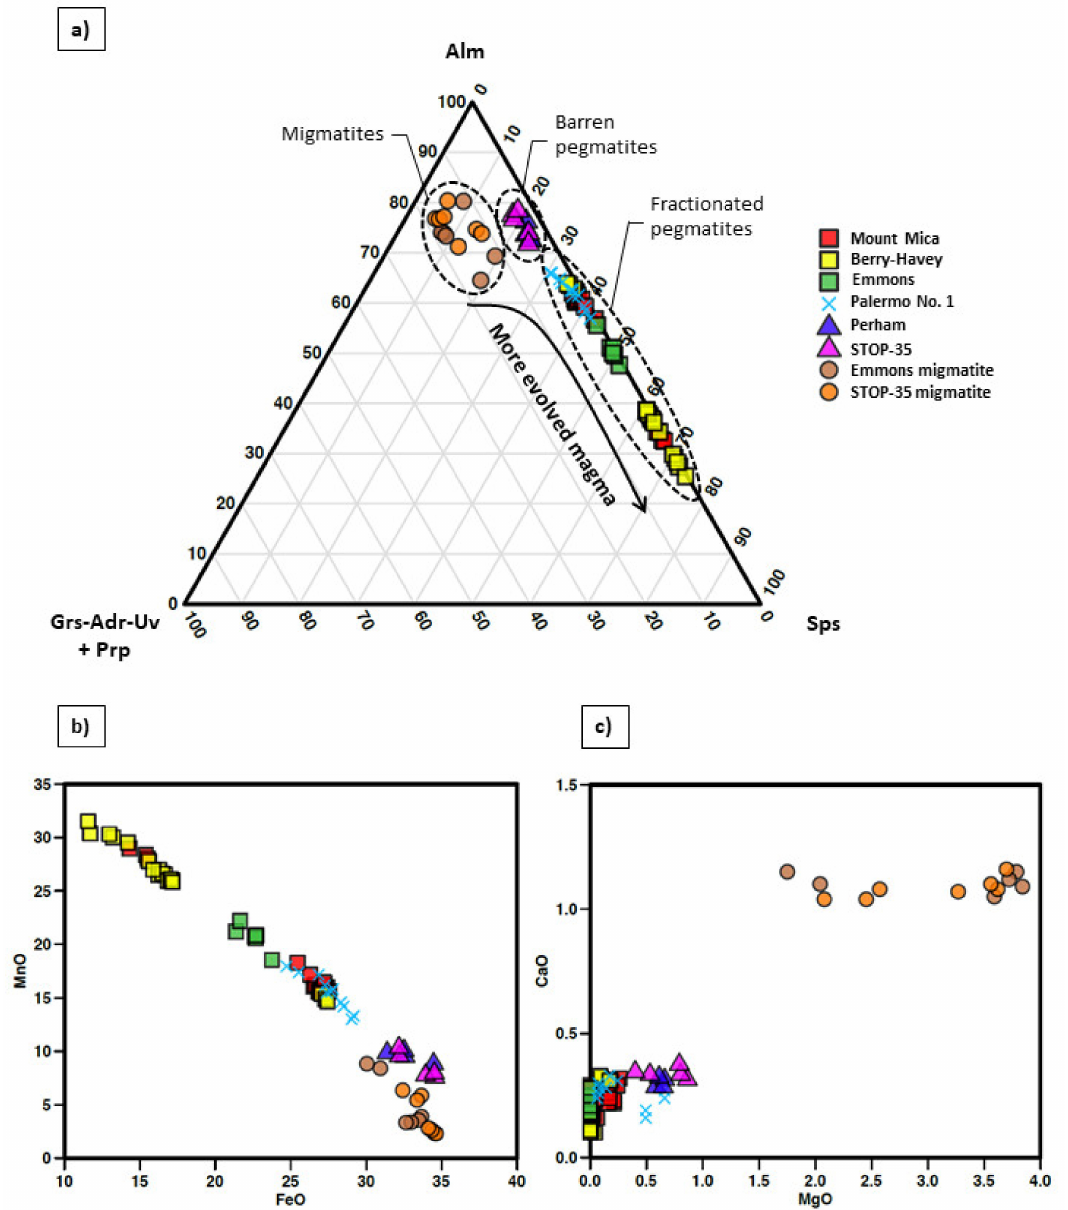
Figure 9. ( a ) Ternary diagram for the Alm—Sps—(Grs-Adr-Uv + Prp) proportions with major garnet end-members. Plots of ( b ) CaO vs. MgO and ( c ) MnO vs. FeO values of garnets from the studied pegmatites and migmatites (values given as